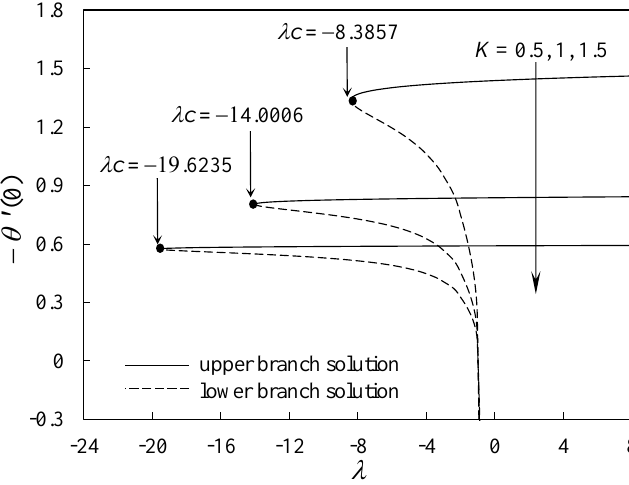
  0    0  with  for several values of K for Ag-water nanofluid. Figure 13. Variation of − θ (cid:48) ( 0 ) with λ for several values of K for Ag-water with  for several values of K for Ag-water nanofluid.